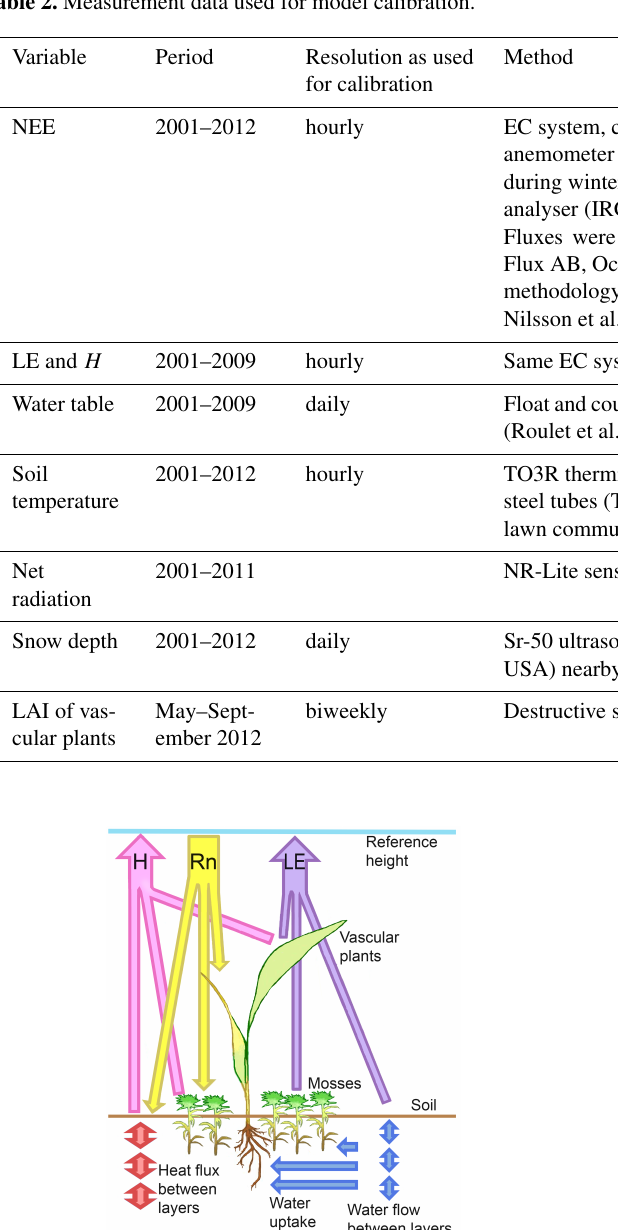
Table 2. Measurement data used for model calibration.